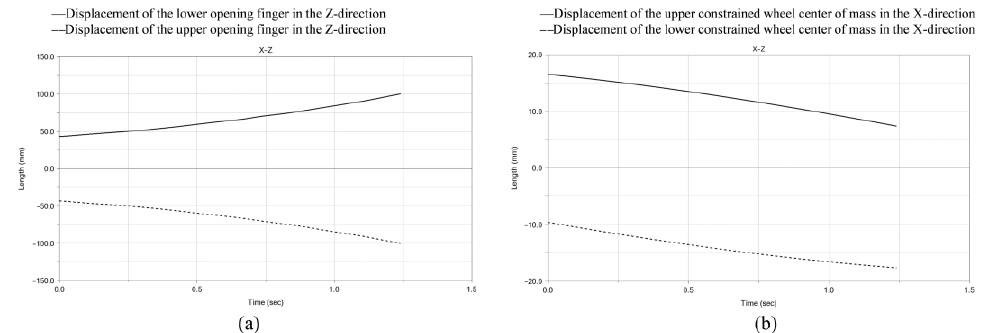
Figure 19. ADAMS View simulation results: ( a ) Open finger displacement in the Z direction; ( b ) Displacement of the upper constraint wheel in the X and Z directions.